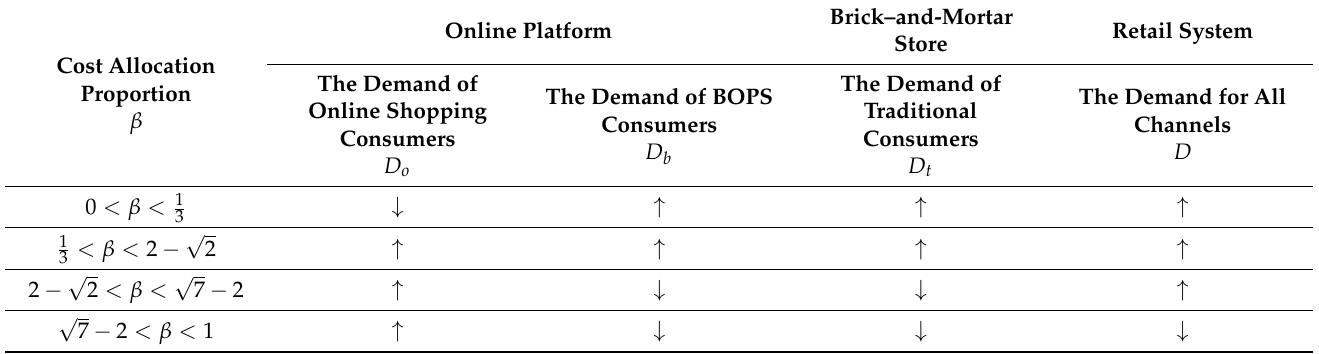
Table 3. The variation in demand with the cost-sharing